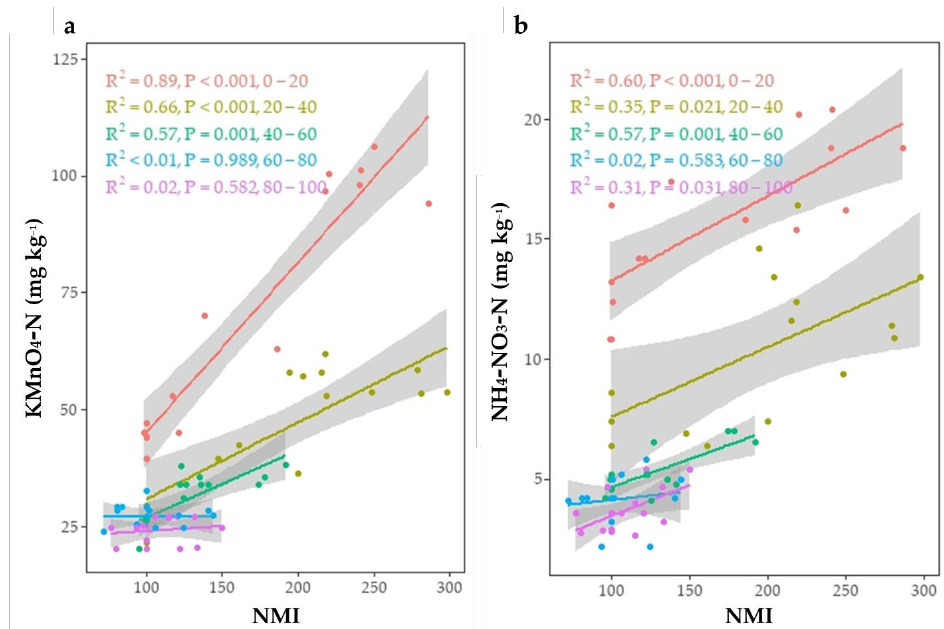
Figure 4. Relationship between nitrogen management index (NMI) with ( a ) KMnO 4 oxidizable organic nitrogen (KMnO 4 -N) and ( b ) mineral N (NH 4 -N + NO 3 -N) at different soil depths.